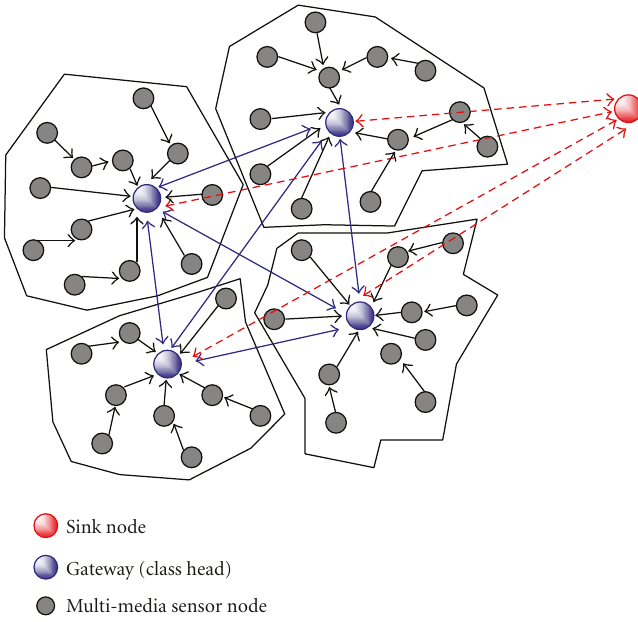
Figure 1: Network architecture.